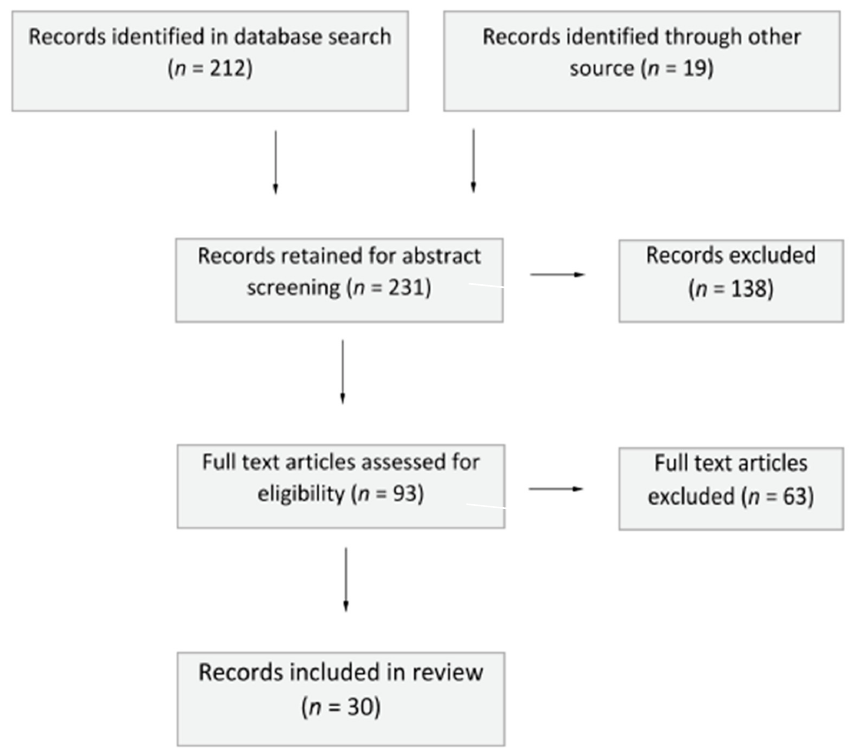
Figure 1. Flow chart of record identification, selection, and inclusion of articles.